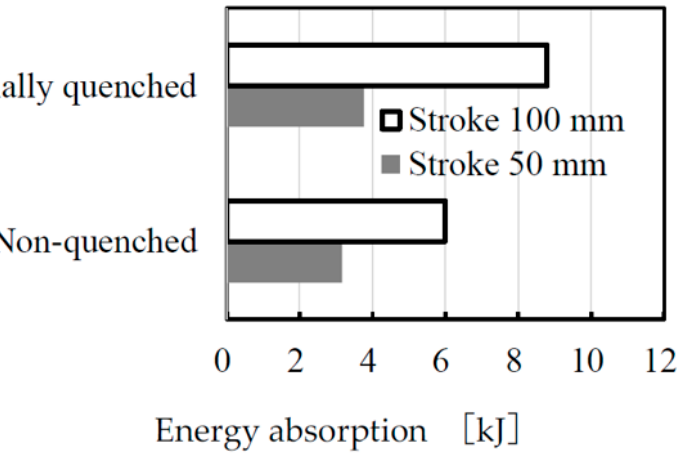
Figure 10. Energy absorption of the partially quenched straight tube in the axial crash